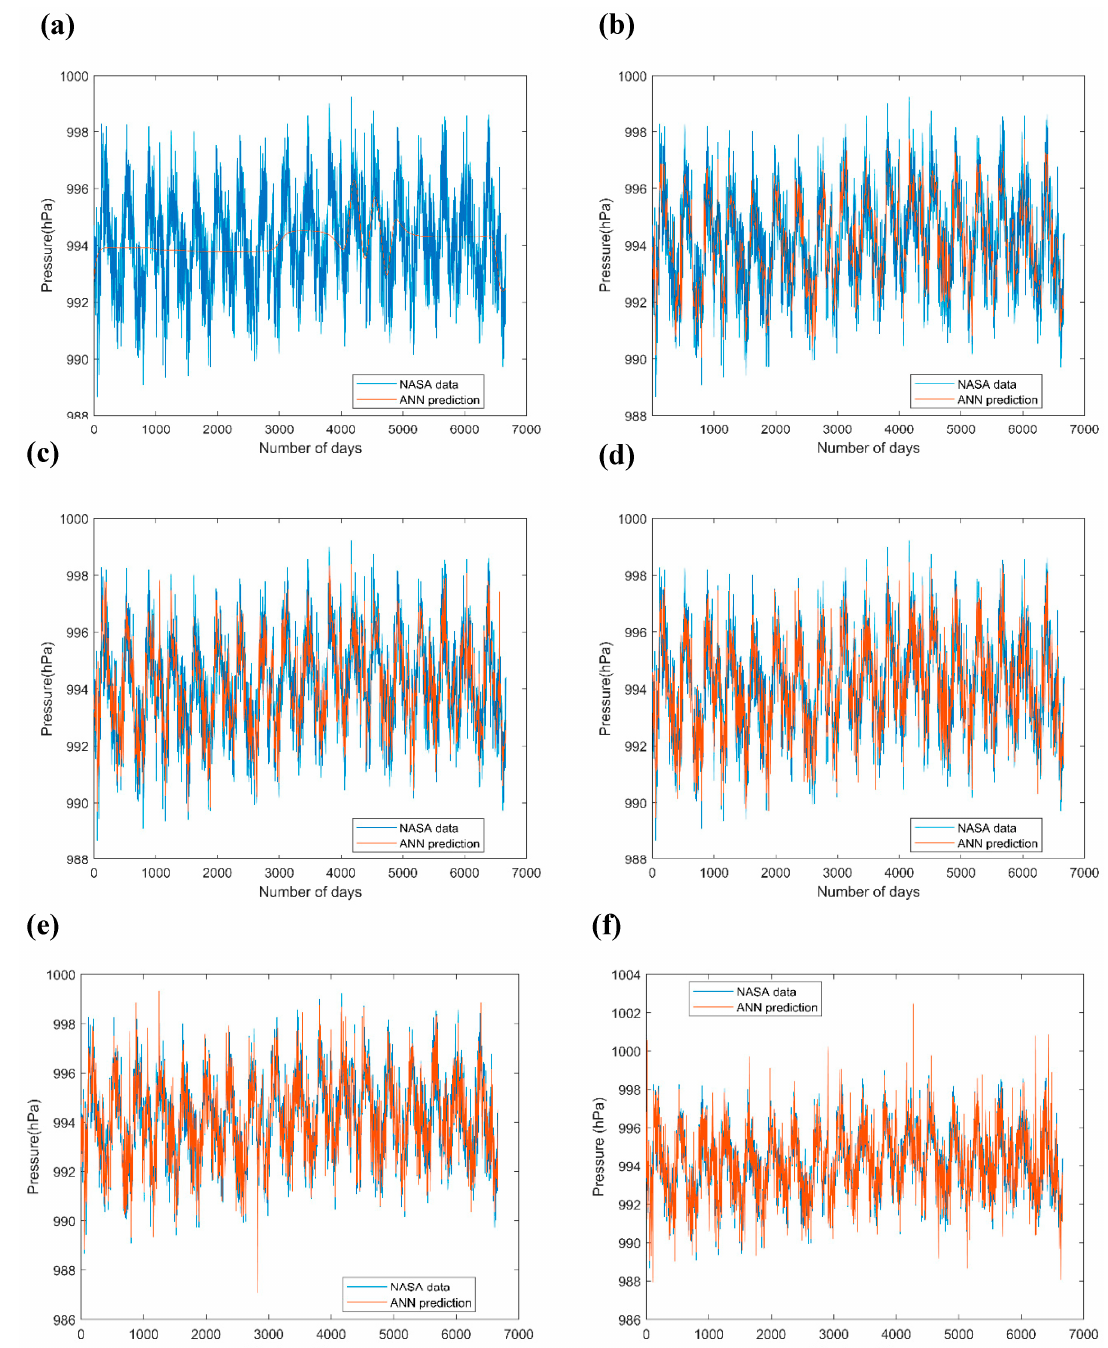
Figure 6. Pressure plot of the NASA data vs. the ANN model with ( a ) 10 hidden units, ( b ) 500 hidden units, ( c ) 1000 hidden units, ( d ) 1500 hidden units, ( e ) 2000 hidden units, and ( f ) 2500 hidden units.